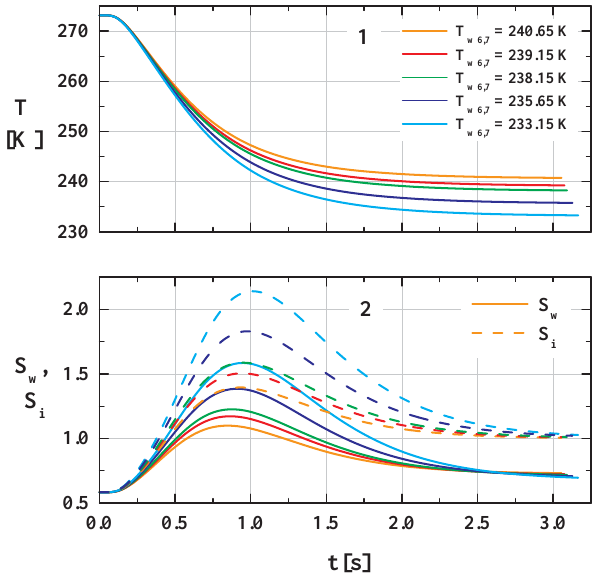
Fig. 3. Profiles at LACIS centerline for different wall temperature Fig. 13. Profiles at LACIS centerline for different wall temperature settings. Panel 1 shows temperature, panel 2 depicts saturation wrt. settings. Panel 1 shows temperature, panel 2 depicts saturation wrt. water (solid lines) and ice (dashed lines). water (solid lines) and ice (dashed lines).